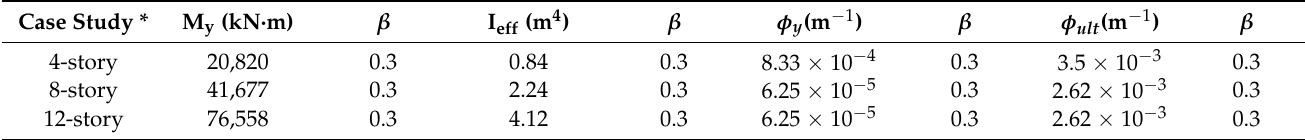
Table 3. Uncertain modeling parameters considered for three case study